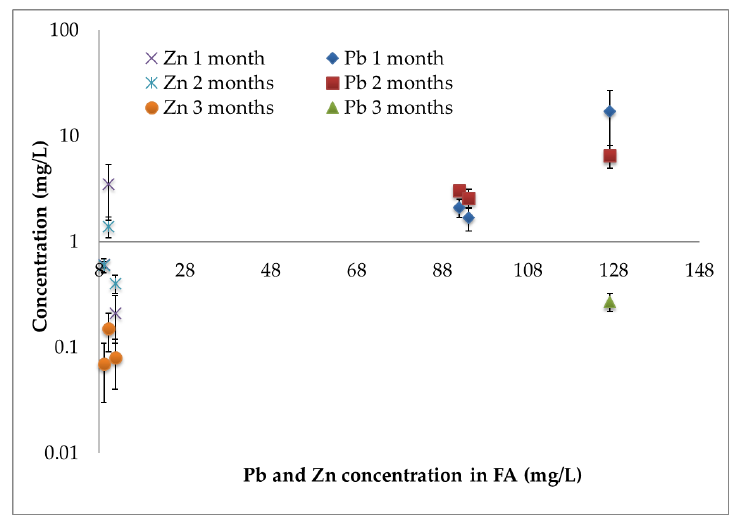
Figure 3. Concentration values of Pb and Zn in the leaching solution of stabilized samples (involving both procedures a) and b)) during the first three months versus the concentration of Pb and Zn in MSWI FA.